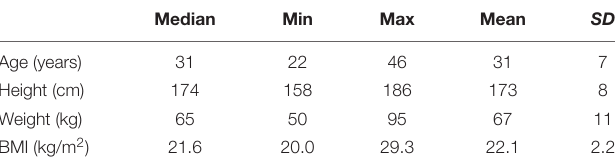
TABLE 1 | Demographic data ( N = 18).